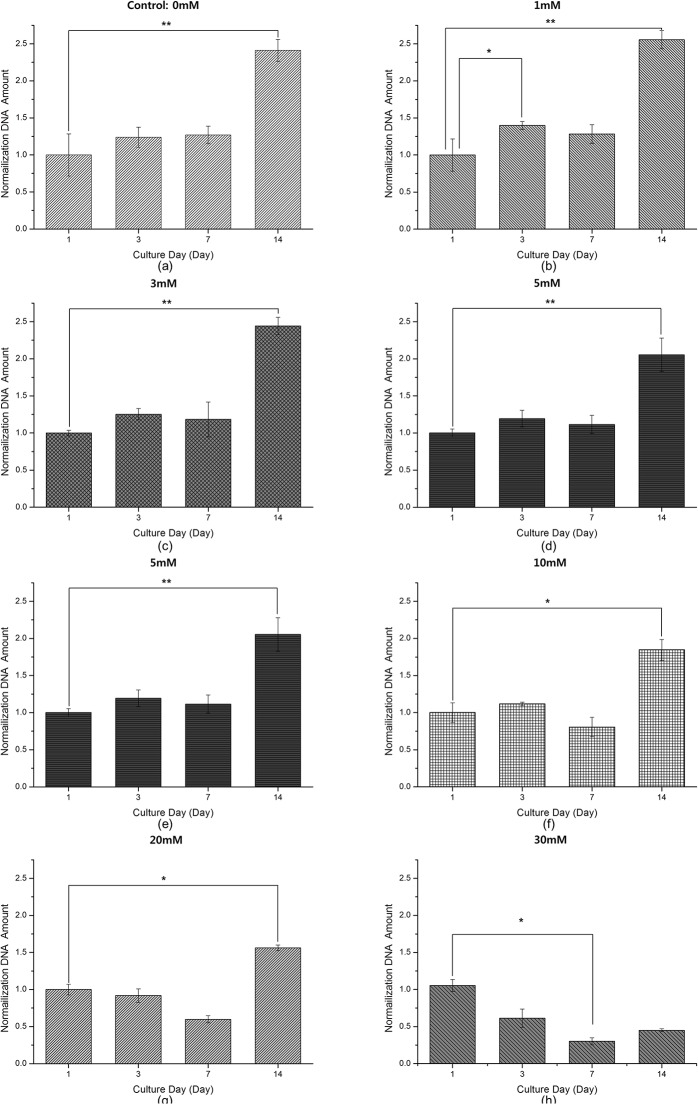
Changes in normalized DNA levels in samples of MG-63 cells during culture with various TSP concentrations: (a) 0 mM, (b) 1 mM, (c) 5 mM, (d) 10 mM, (e) 20 mM and (f) 30 mM.(n = 10, *: p<0.05, **: p<0.01).